Question: Give a one-sentence summary of this figure.
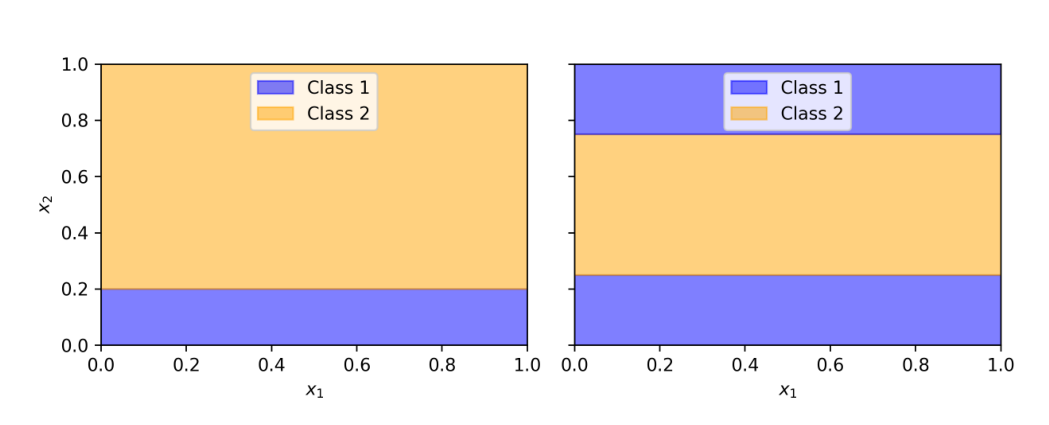
Answer: Division of the feature space based on two different taxonomy functions. The first one simply thresholds the second dimension (at ξ = 0.2), whereas the second one performs equal-frequency binning on the (conditional) standard deviation, which has the form shown in Eq. (8).